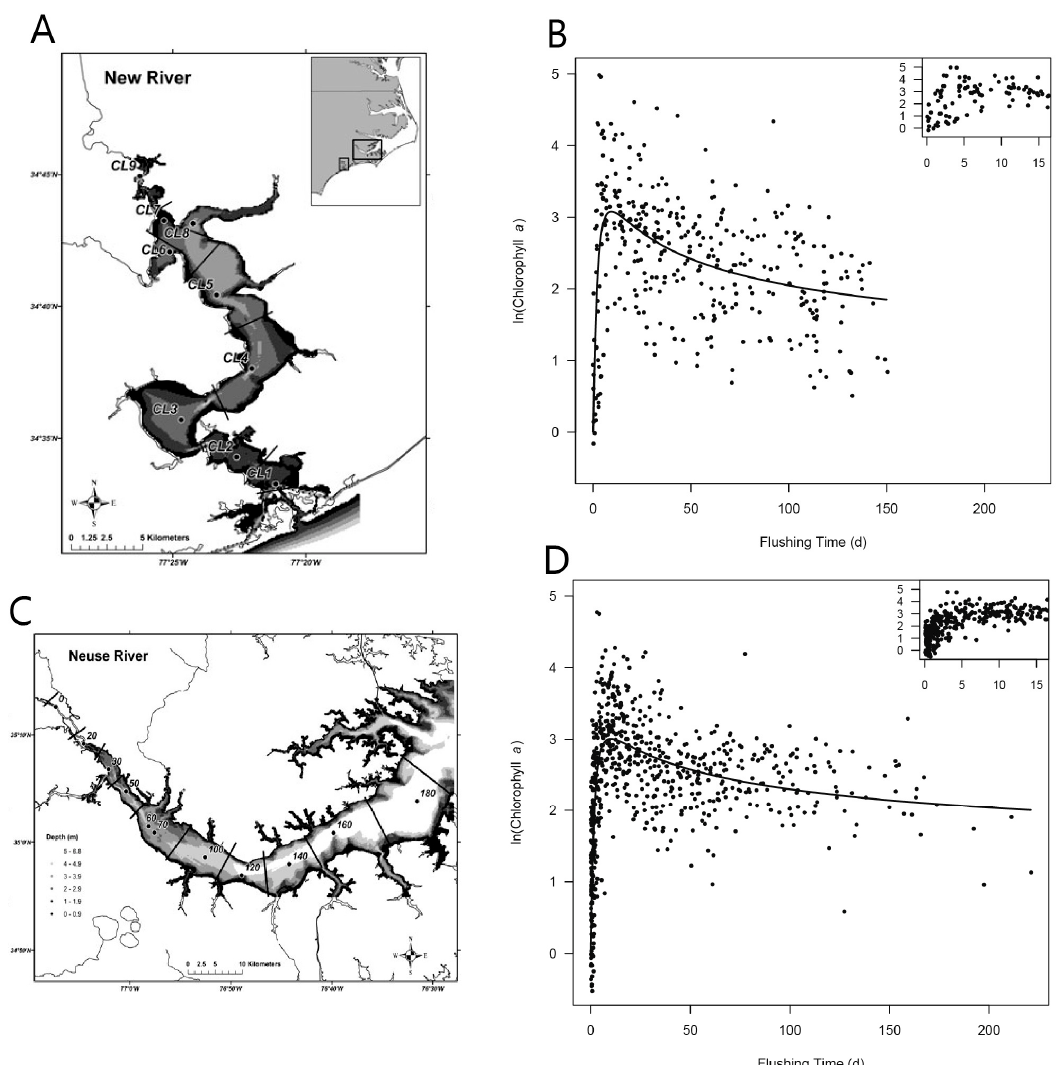
Figure 23. From Peierls et al. [57], maps of the ( A ) New River Estuary (NewRE) and ( C ) Neuse River Estuary (NRE); for the ( B ) NewRE and ( D ) NRE, observation based ln(chlorophyll a ) versus flushing time estimated with the “date-specific freshwater replacement method” [239]. (Adapted by permission from Springer Nature Customer Service Center GmbH: Springer Nature, Estuaries and Coasts, Non-monotonic Responses of Phytoplankton Biomass Accumulation to Hydrologic Variability: A Comparison of Two Coastal Plain North Carolina Estuaries, Peierls et al., 2012. https://www.springer.com/journal/12237).